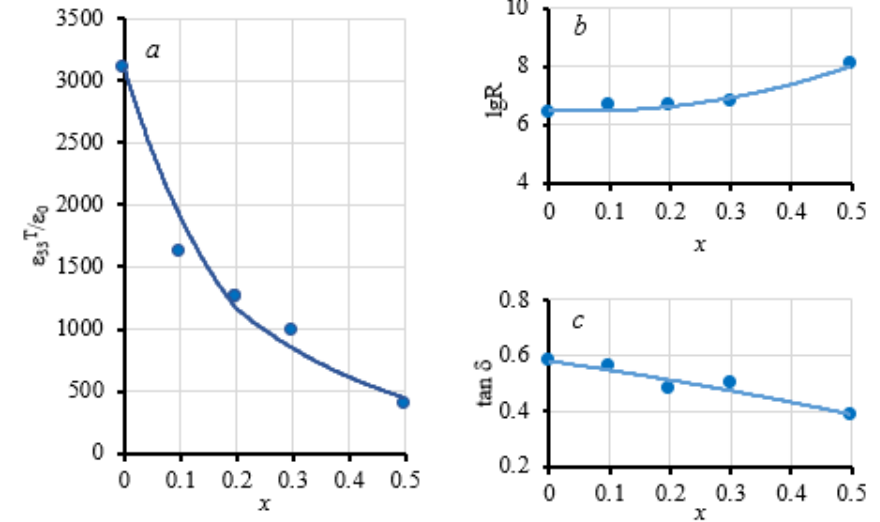
Figure 9. The concentration dependence of the dielectric constant ( a ), the logarithm of the electrical resistivity ( b ), and the dielectric loss tangent ( c ) of composite ceramics 50 wt.% PZTNB-1 + 50 wt.% Pb 1 − x La x Fe 12 − x Zn x O 19 .